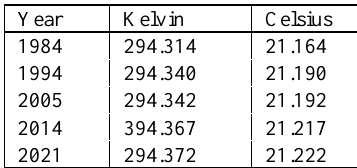
Table 2. Calculated average temperature for the years 1984 to 2021 in Kelvin and degrees Celsius.